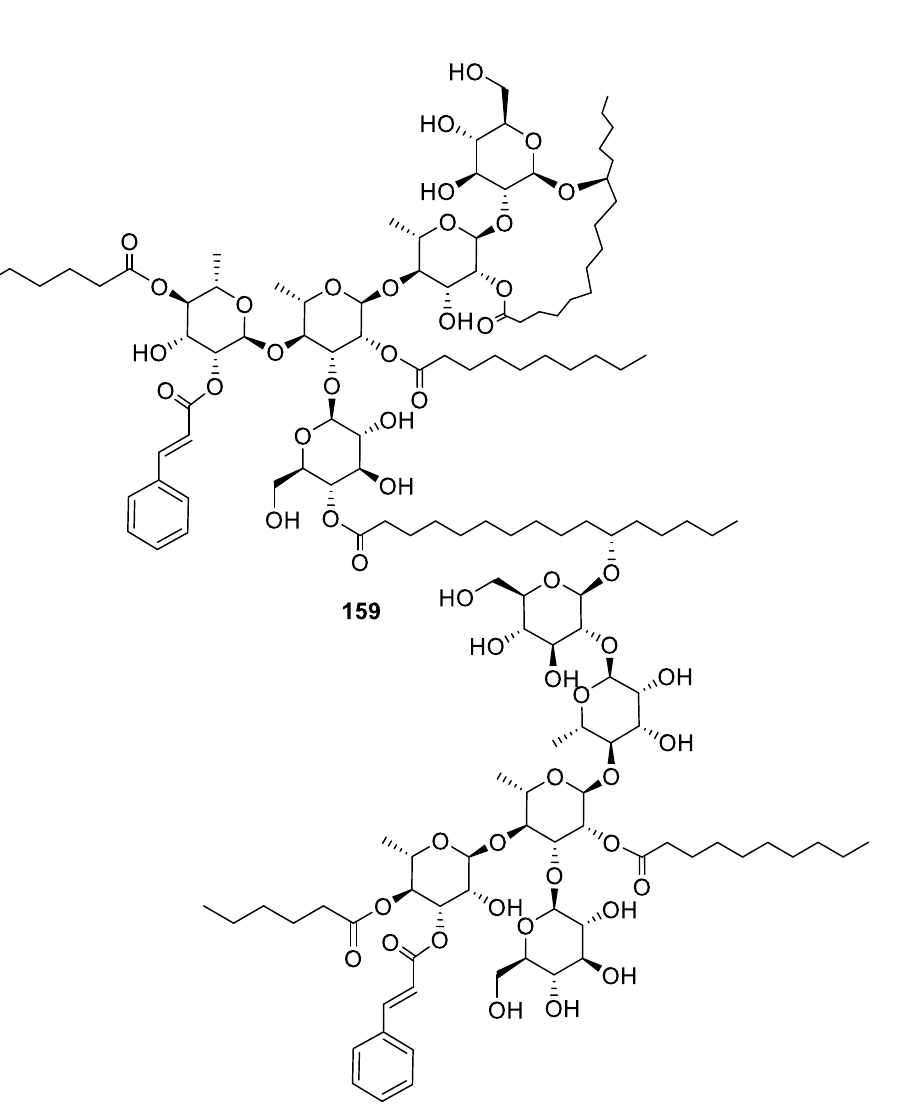
Figure 4. Carbohydrates and a cyclitol from Mexican plants with hypoglycemic activity.